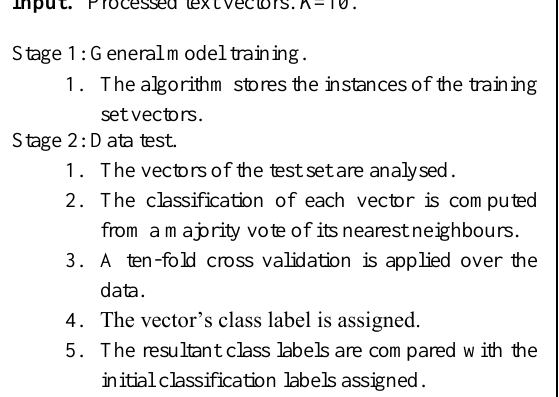
Algorithm 2. Representation of the cleaned_text field of each